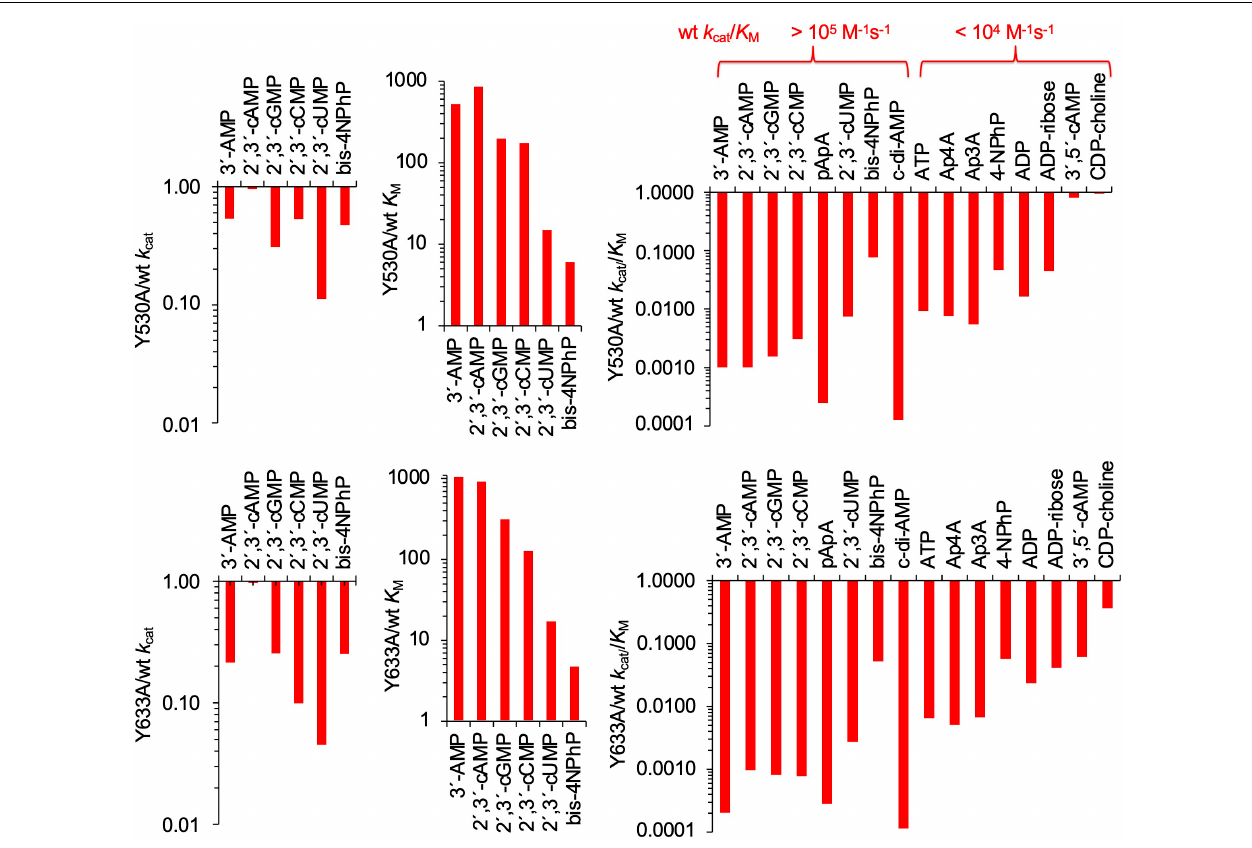
FIGURE 4 | Effects of Y530A and Y633A mutations on kinetic parameters of SntA. Absolute values of k cat , K M , and k cat / K M are shown in Tables 2 , 3 . Panels show in log scale ratios of these data vs. wild-type parameters of Table 1 . The indication made in upper end of right panels classifies substrates into two groups depending on their wild-type catalytic efficiencies, here called good and poor SntA